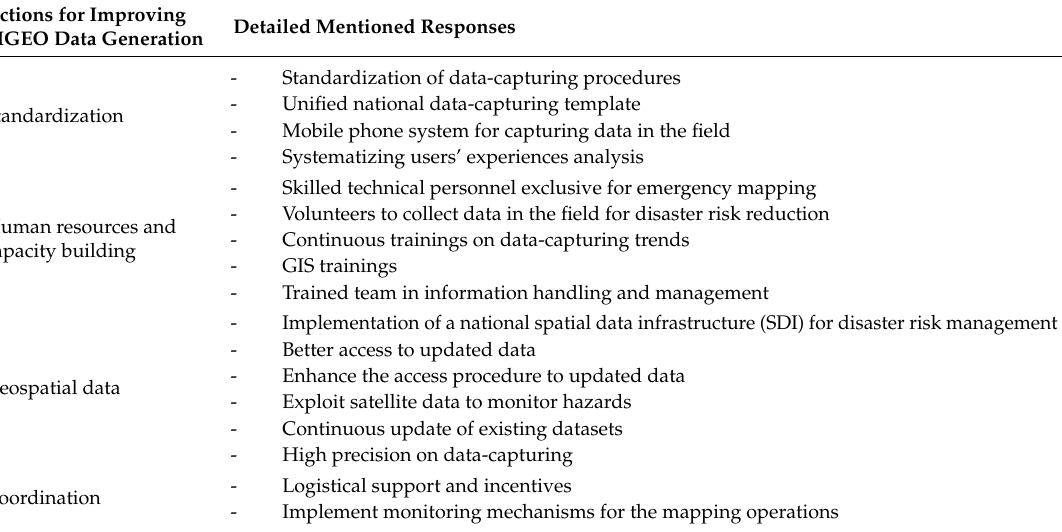
Table 3. Recommendations for EIGEO data generation (b) (Q25) .